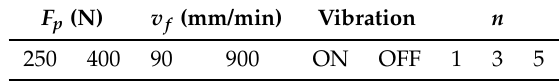
Table 2. Parameters varied and combined during different burnishing